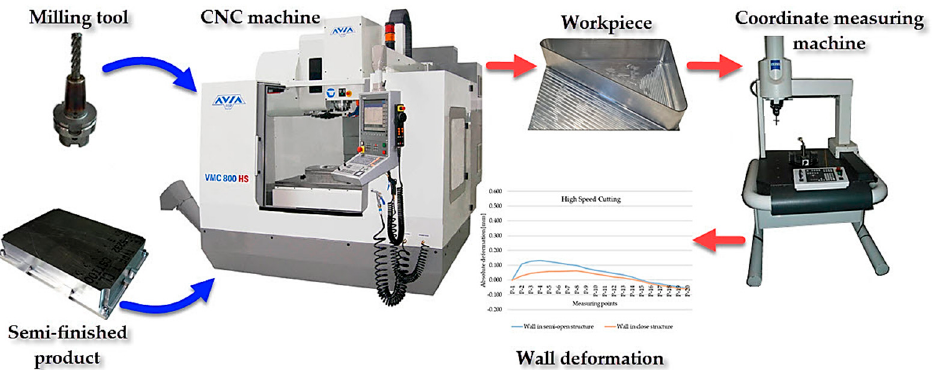
Figure 2. Study object model.